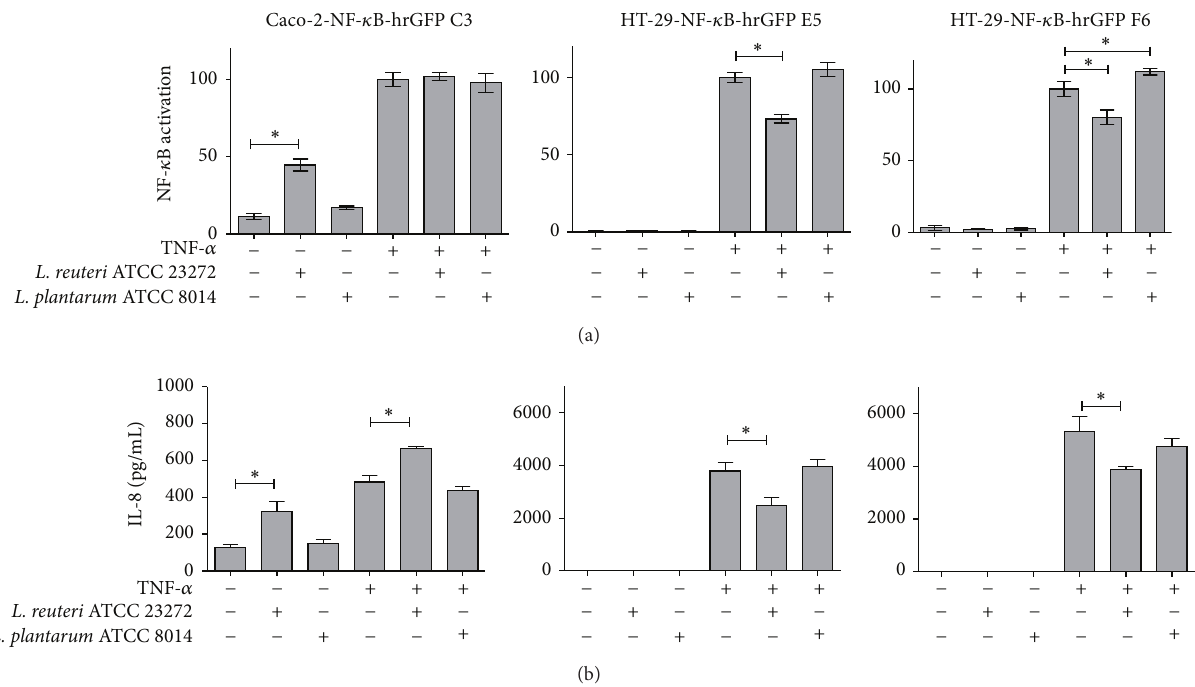
Figure 7: Caco-2-NF- 𝜅 B-hrGFP C3 and HT-29-NF- 𝜅 B-hrGFP E5 and F6 clones showed different NF- 𝜅 B activation (a) and IL-8 production (b) in response to LAB. Caco-2-NF- 𝜅 B-hrGFP C3 cells were seeded at 1 × 10 5 cell/well, while HT-29-NF- 𝜅 B-hrGFP E5 and F6 clones were seeded at 5 × 10 4 cell/well, cultured ON, and treated for 2h with L. reuteri ATCC 23272 or L. plantarum ATCC 8014. Then, gentamycin and TNF- 𝛼 (1ng/mL) were added; 48 h or 18–24 h later (for Caco-2-NF- 𝜅 B-hrGFP C3 and HT-29-NF- 𝜅 B-hrGFP E5 and F6, resp.), cells were trypsinized and NF- 𝜅 B activation (measured by the % GFP + cells) was analyzed by flow cytometry. Cell viability was over 90% for all tested conditions. Data was normalized against TNF- 𝛼 control (considered as 100%). IL-8 quantification was performed in the harvested cell culture supernatant by flow cytometry. Results were expressed as the mean ± SD of triplicates of a representative experiment. ∗ 𝑃 < 0.05 using One-Way ANOVA with Dunnett’s